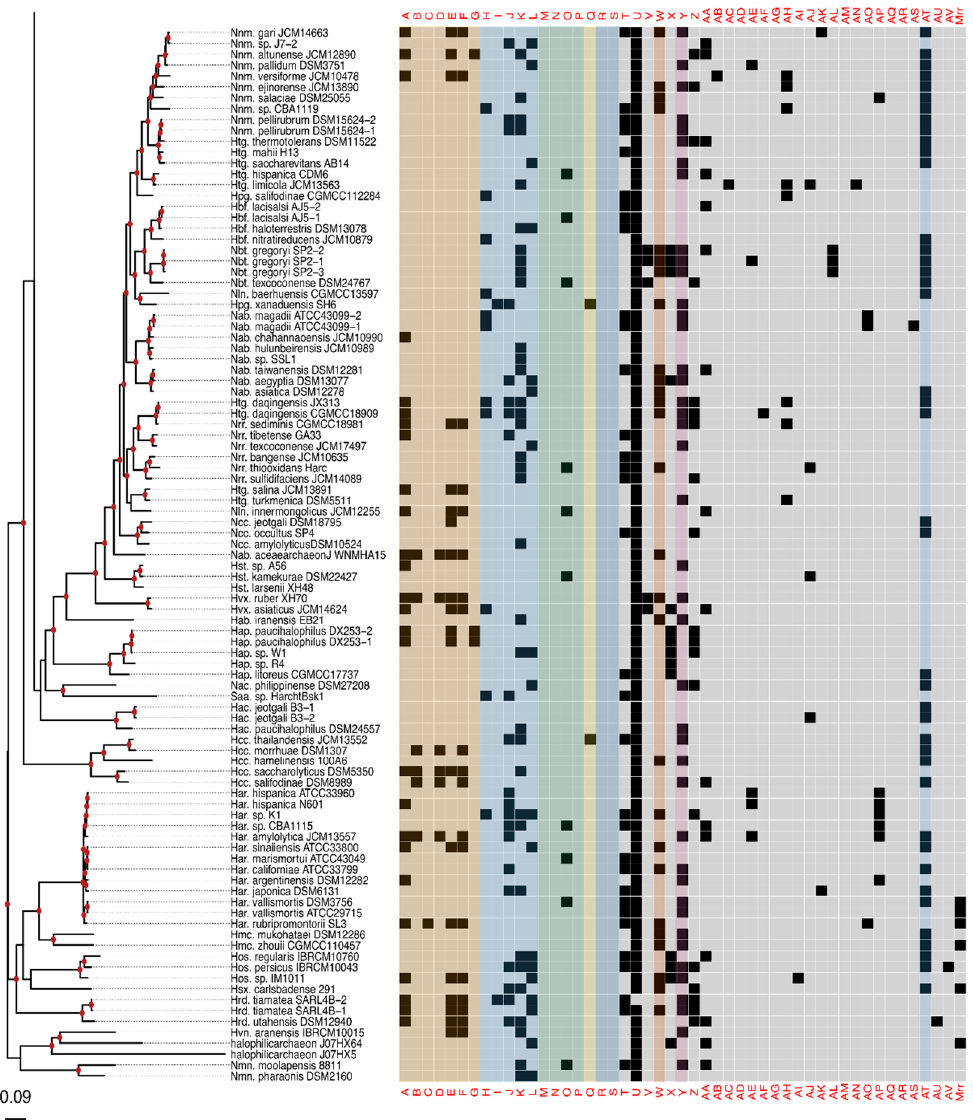
Figure 2. Presence–absence matrix of the 48 candidate RMS cHGs plotted against the reference phylogeny. For most cHGs the pattern of presence–absence does not match the reference phylogeny (compare Figures S2–S5). RMS-candidate cHGs are loosely ordered by system type and with the ambiguously assigned RM candidates at the end. Table 1 gives a key relating the column names to the majority functional annotation.